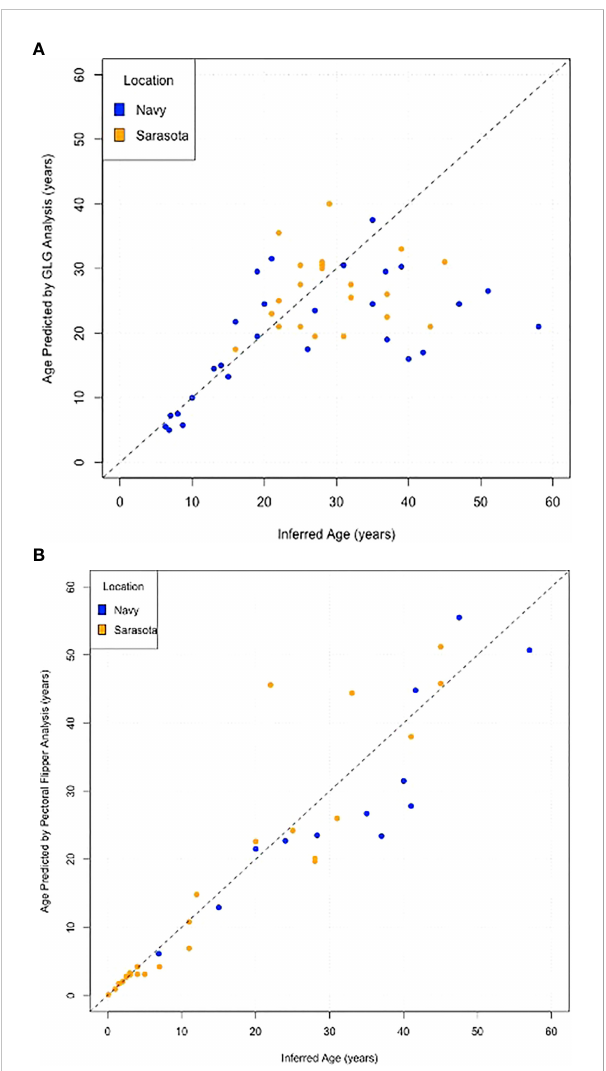
FIGURE 5 Scatter plots of Inferred age versus Estimated age for (A) Tooth growth layer group analysis, (B) Pectoral Flipper Radiography. Dolphins from the Navy Marine Mammal program are represented in blue and dolphins from Sarasota Bay are in orange. Dashed 45° line represents exact agreement.